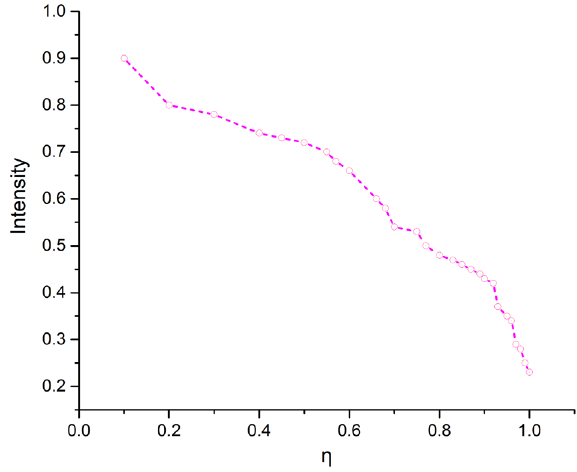
Figure 3. The effects of proposed enhancement parameter η on